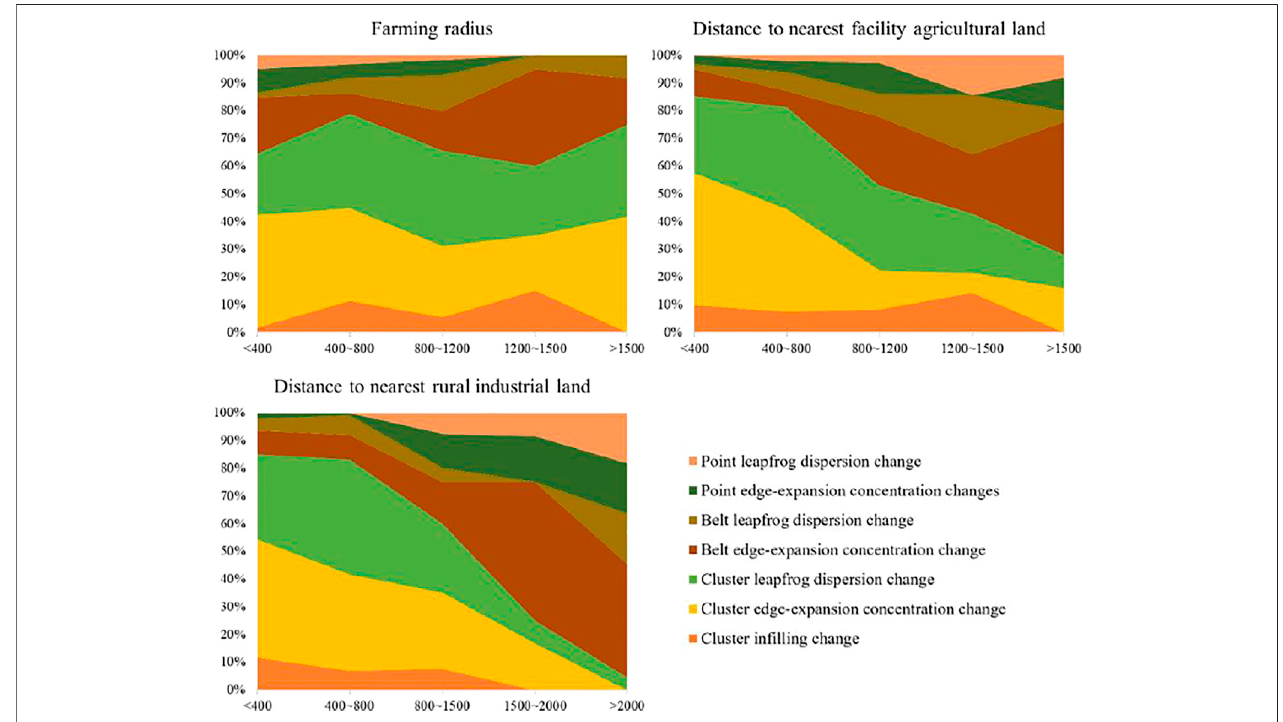
FIGURE 11 | Distribution characteristics of the dynamic spatial pattern of RRL under the production condition